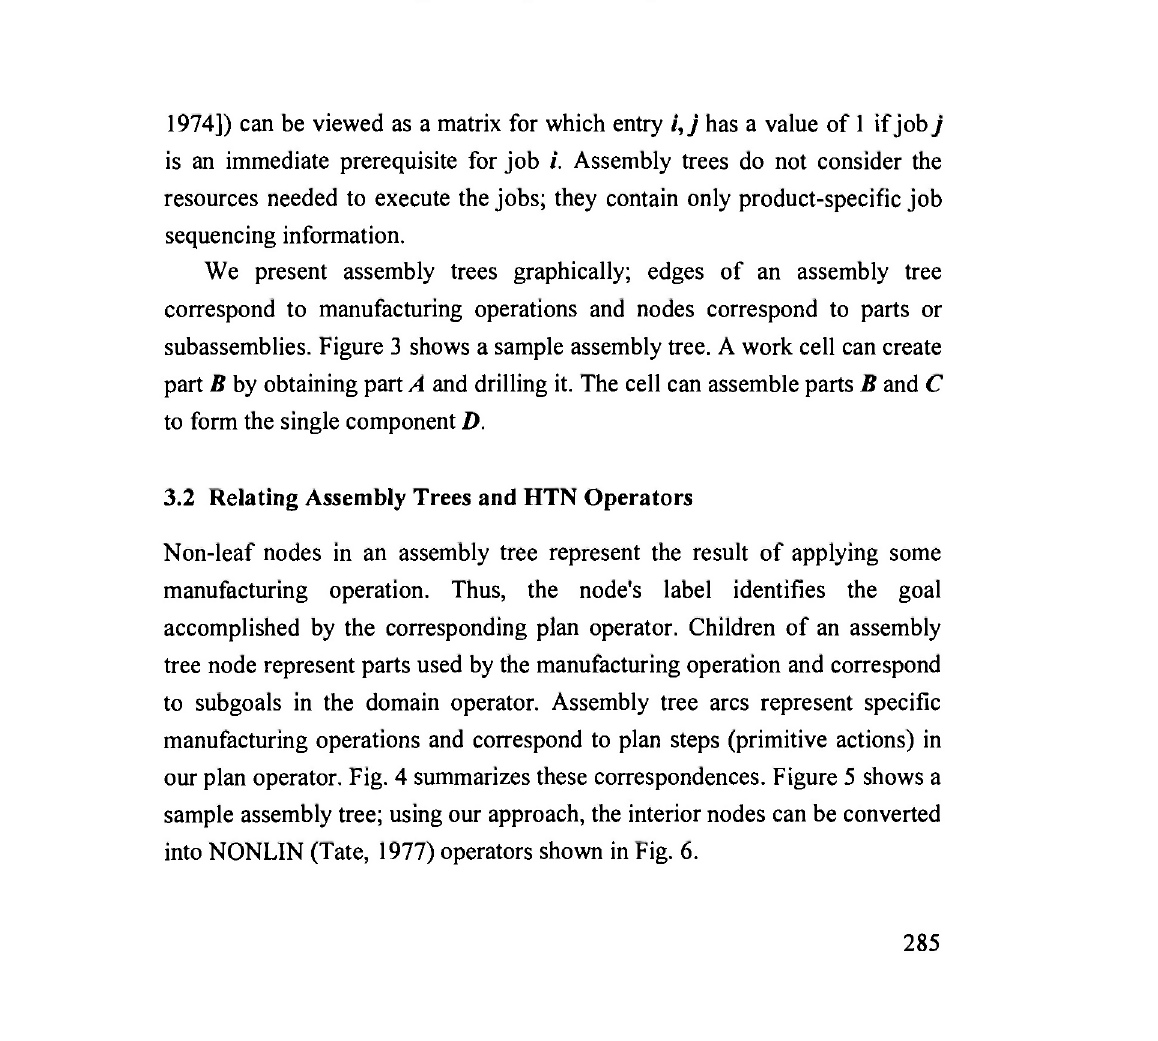
Fig. 3: Sample Assembly